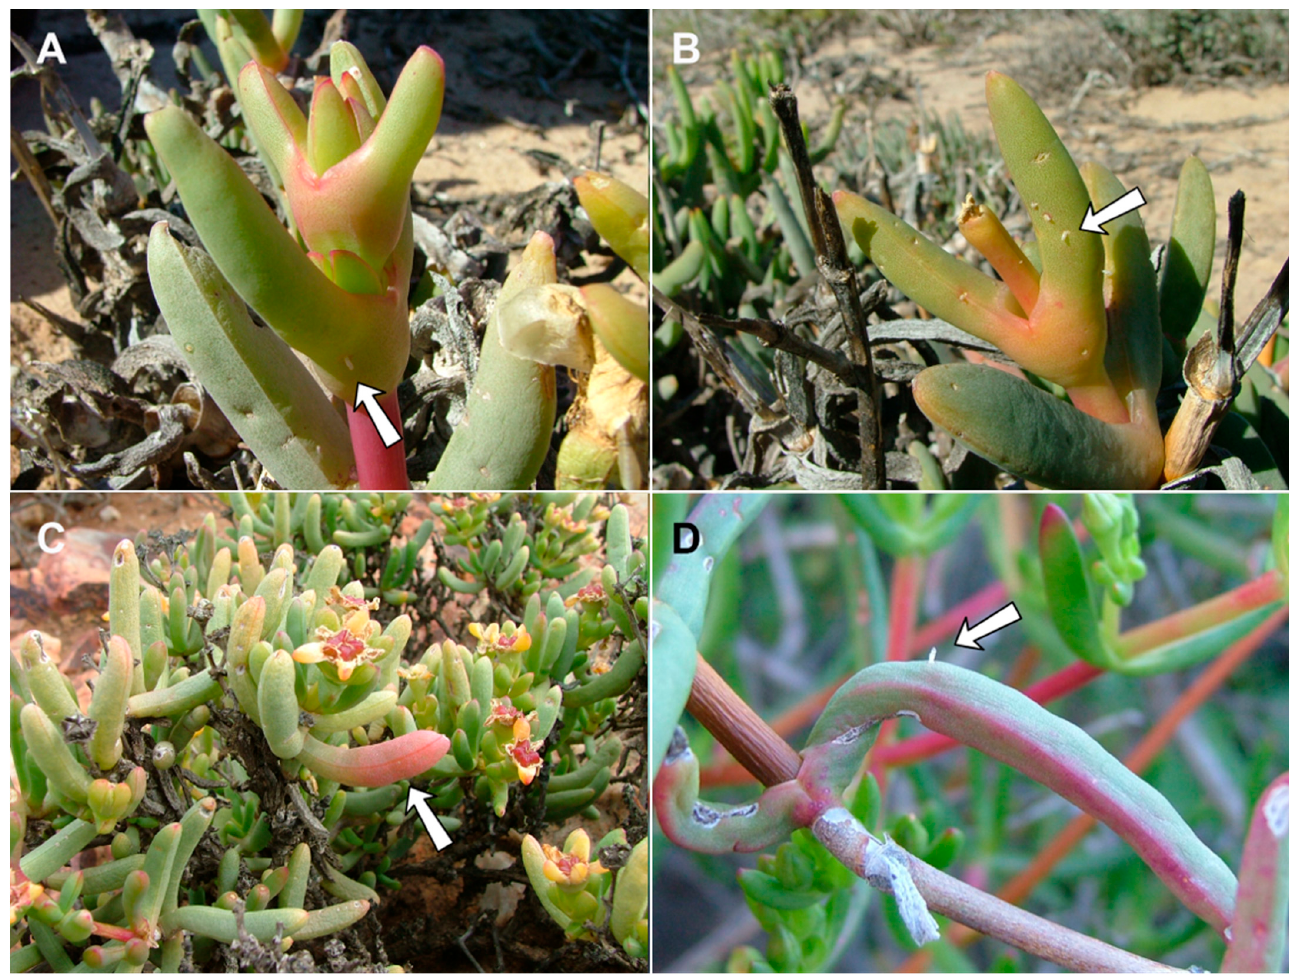
Figure 13. Ruschiola galls. ( A , B ) R. bubonis on Jordaaniella spongiosa (arrows: pupal skins in leaves). ( C ) R. quagga on Ruschia holensis . (arrow: galled leaf) ( D ) R. timida on Scopelogena bruynsii (arrow: pupal skin in leaf). Adult : Head : Antennal flagellomeres 12–14 in female ( n = 10), 11–13 in male ( n = 5).